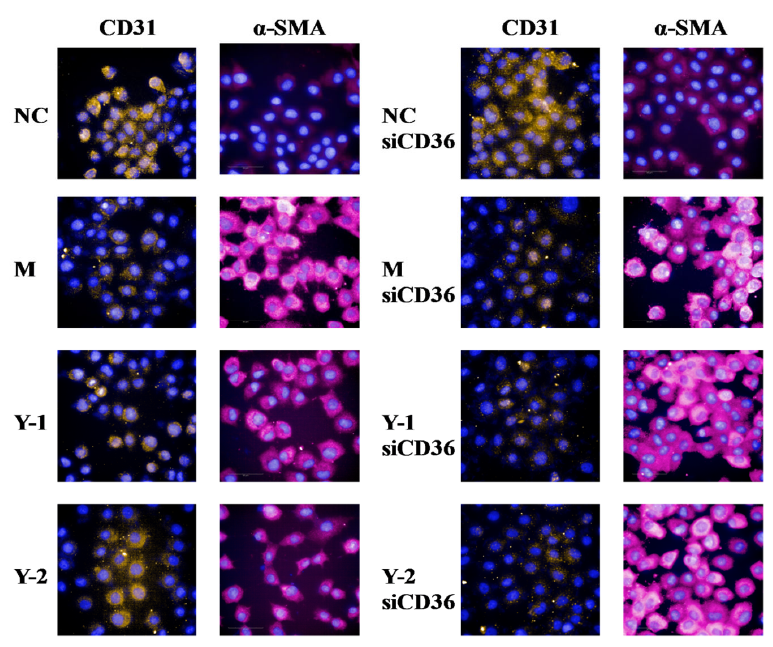
Figure 7. Cell immunofluorescence of EMT ‐ related proteins CD31 and α‐ SMA.